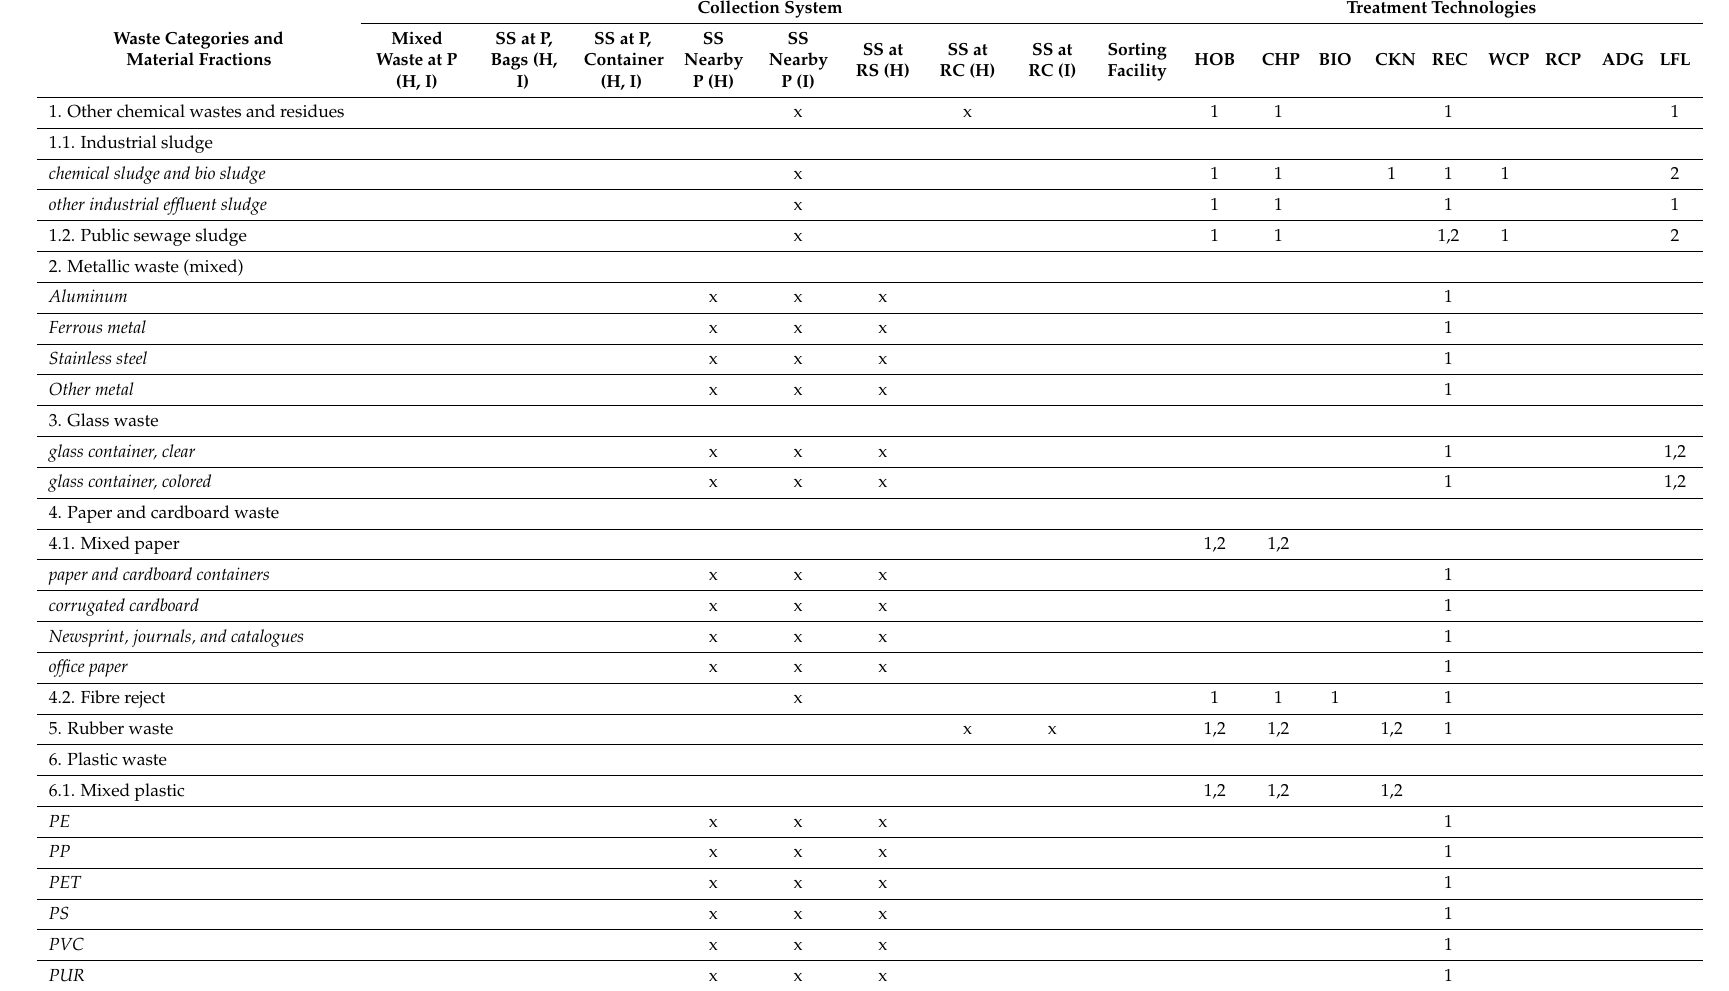
Table A1. Overview of material fractions and